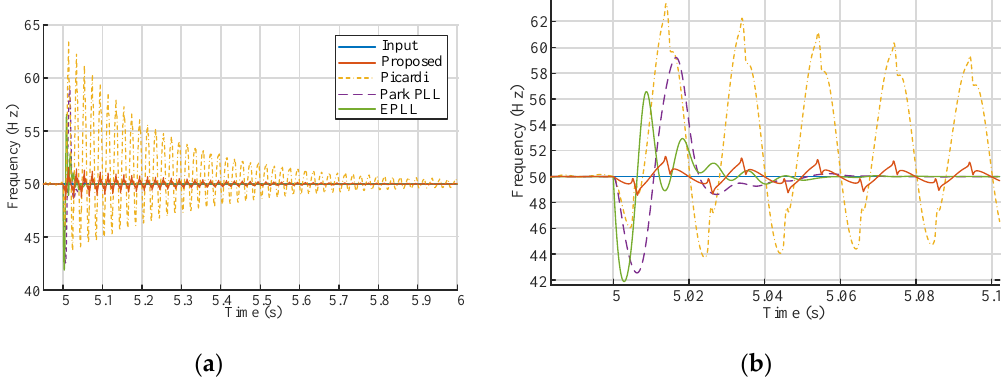
Figure 19. Comparison of frequency detection techniques for a voltage sag from 1 to 0.7 pu (50 Hz) for